Question: Produce a descriptive caption suitable for publication.
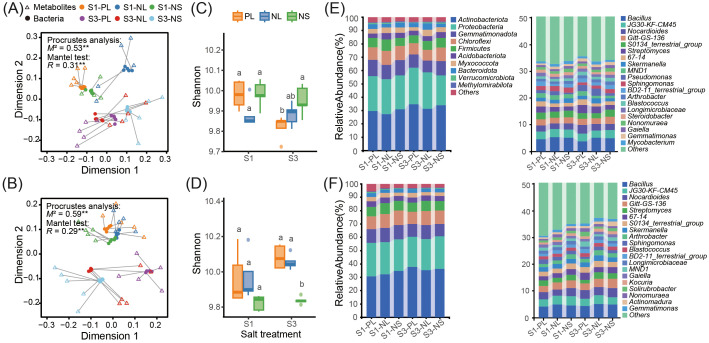
Answer: Rhizosphere bacterial communities. (A, B) Procrustes analysis and Mantel test assessing metabolite-microbiome correlations; (C, D) Bacterial community diversity indices; (E, F) Relative abundances of the top 10 bacterial phyla and top 20 genera. Panels (A, C, E) Soybean; Panels (B, D, F) Suaeda salsa . PL, Plastic barrier separation; NL, Nylon mesh separation; NS, No separation. Different lowercase letters in (C, D) indicate significant differences ( p = 0.05) among root interaction modes under the same salt treatment.